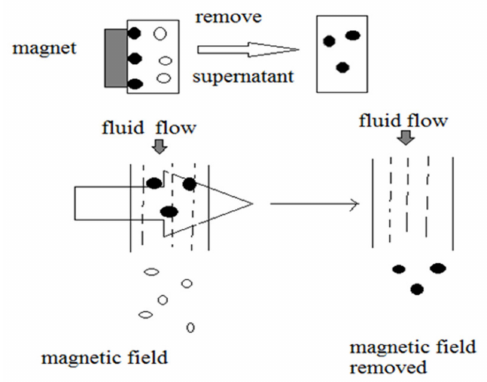
Figure 12. Magnetic separation process. (I) Tagging of desired biological entity with IONPs ( • ); (II) Separation of desired entity-tagged nanoparticles by fluid-based magnetic process ( ◦